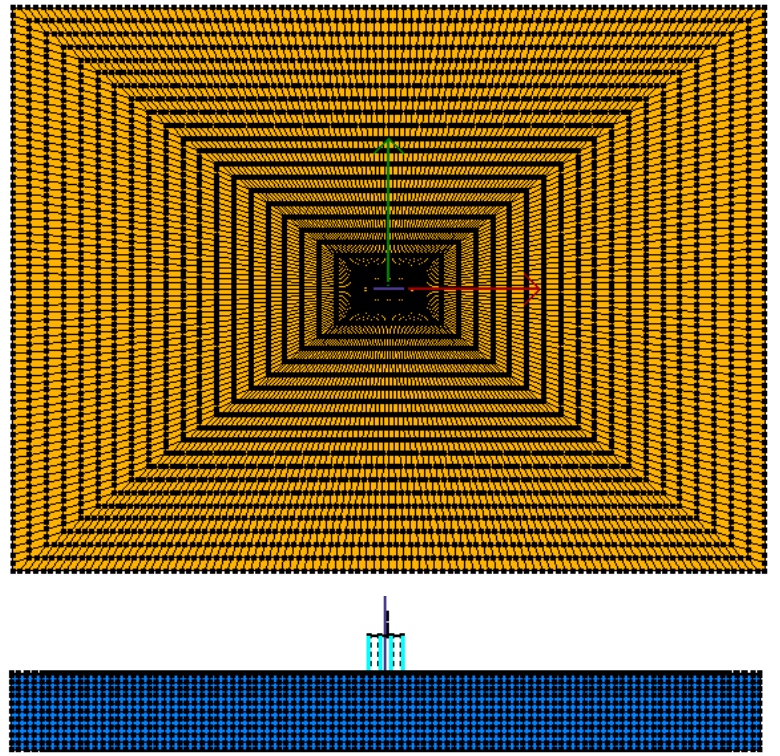
Figure 2. The mesh configurations used in the analyses: structure and soil domain (20 × 120 × 150 m). Table 2. Characteristics of the foundation.